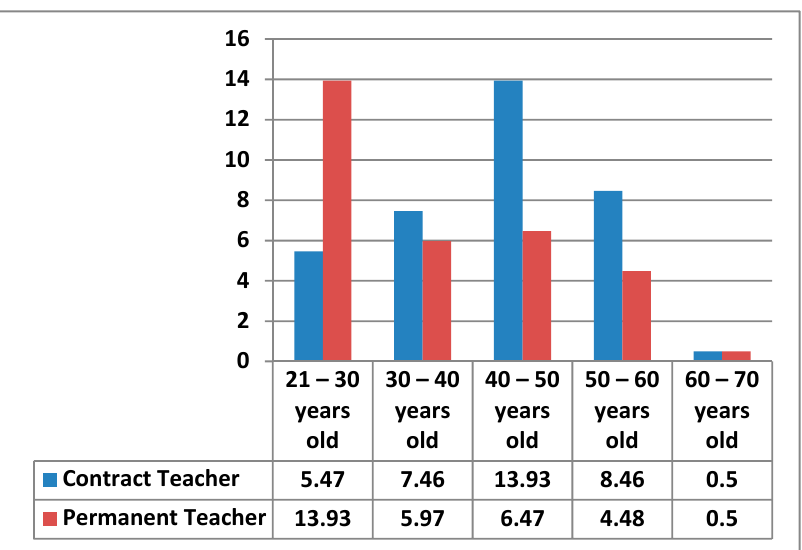
Figure 5. Teaching posts by age.